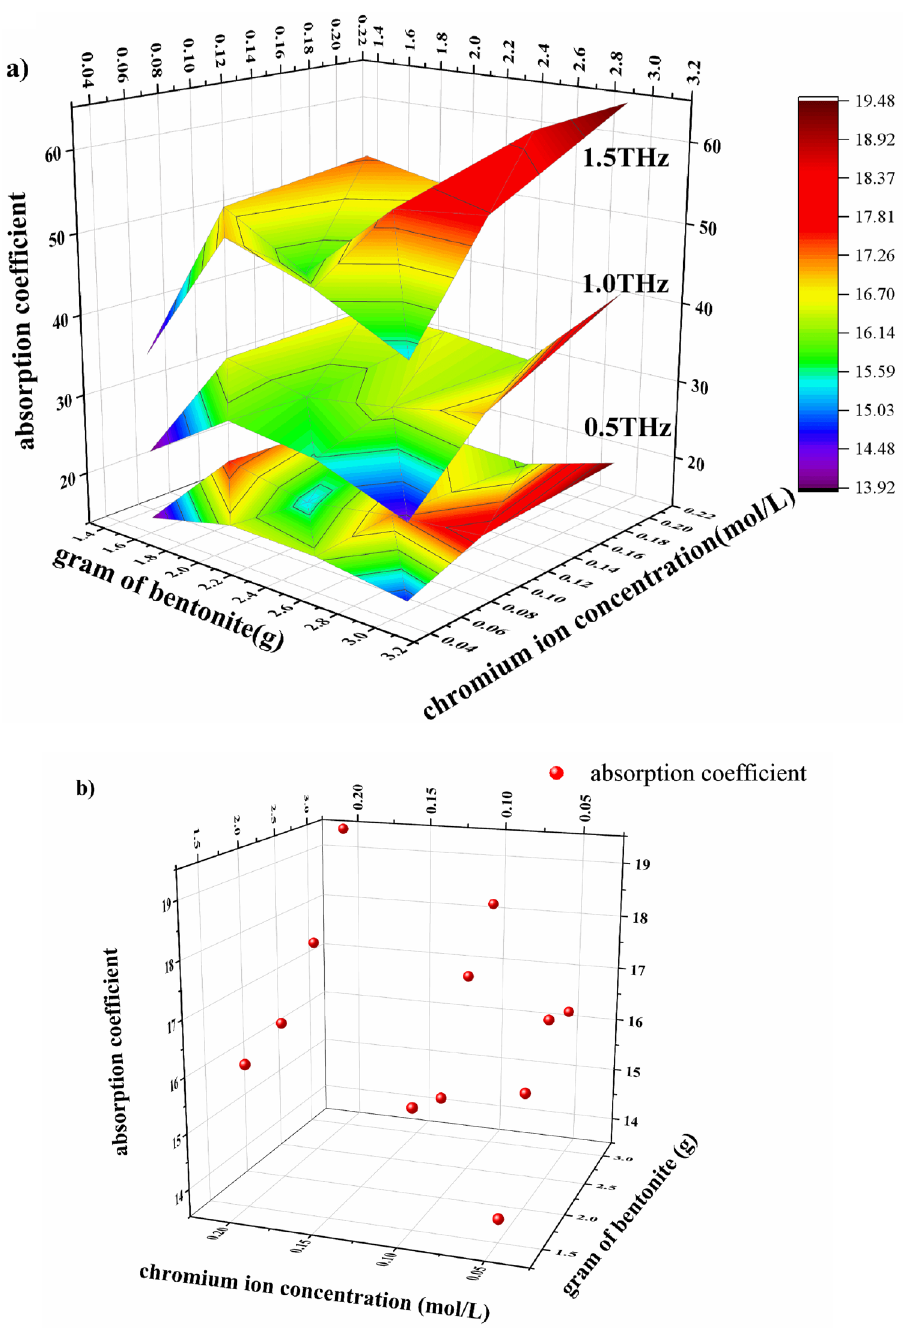
Figure 3. Results of terahertz absorption measurements on bentonite samples at different frequencies. Diagram of absorption relationship at the frequency of 0.5, 1, and 1.5 THz ( a ). Absorption coefficient versus bentonite weight and chromium ion concentration at the frequency of 0.5 THz ( b ). The experiments were carried out at the temperature of 293.15–298.15 K, the pressure of one atmosphere and the humidity of air inside the setup <